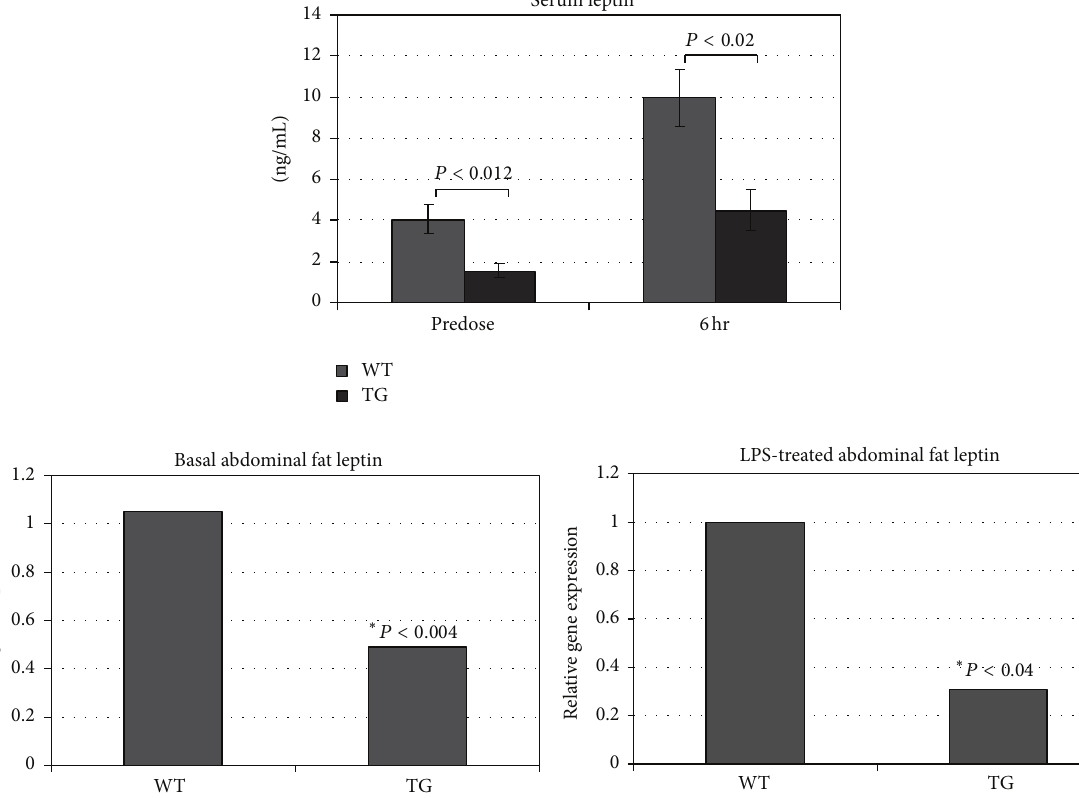
Figure 6: 𝑁𝐴𝐺 - 1 𝑇𝑔/𝐿𝑜𝑥 mice have lower basal and LPS-induced serum leptin concentrations and abdominal fat leptin expression than WT littermates.Theserumcollectedfromtheterminalbleeds(Figure 5)wasanalyzedforleptinusingacytokine-specificELISA.RNAwasisolated from the isolated abdominal fat tissue, which was analyzed for relative expression of mouse leptin mRNA using